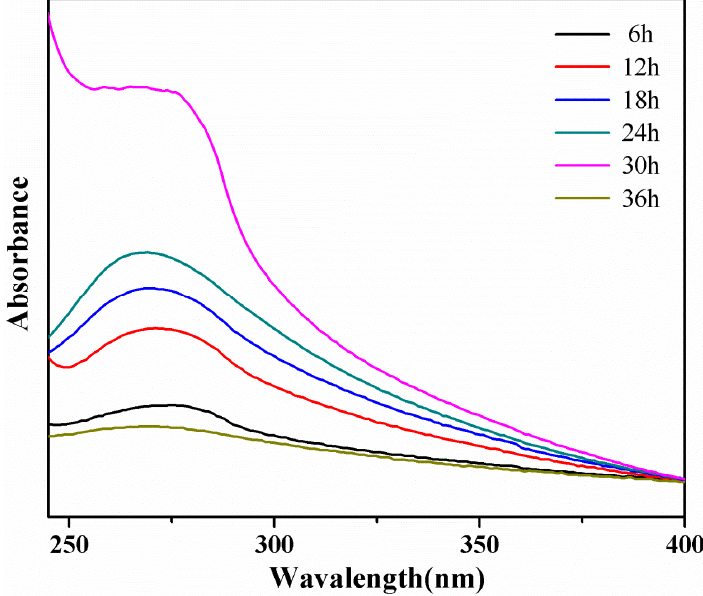
Figure 1. UV–vis absorption spectra of graphene with ultrasonic time.